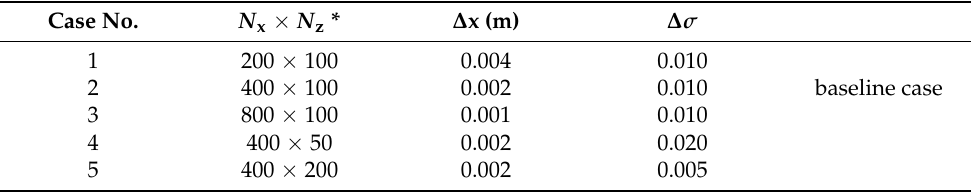
Table 2. A summary of grid settings in the lock-exchange case. Case